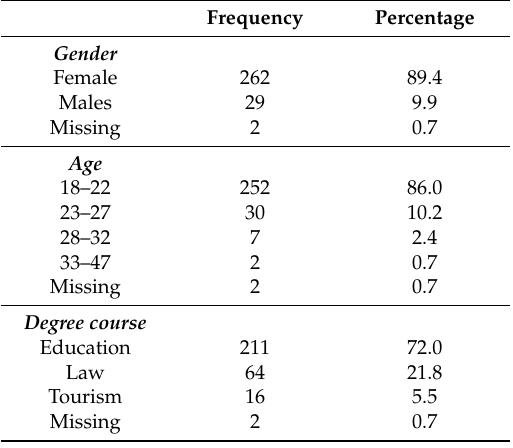
Table 1. Demographic information on students participating in the